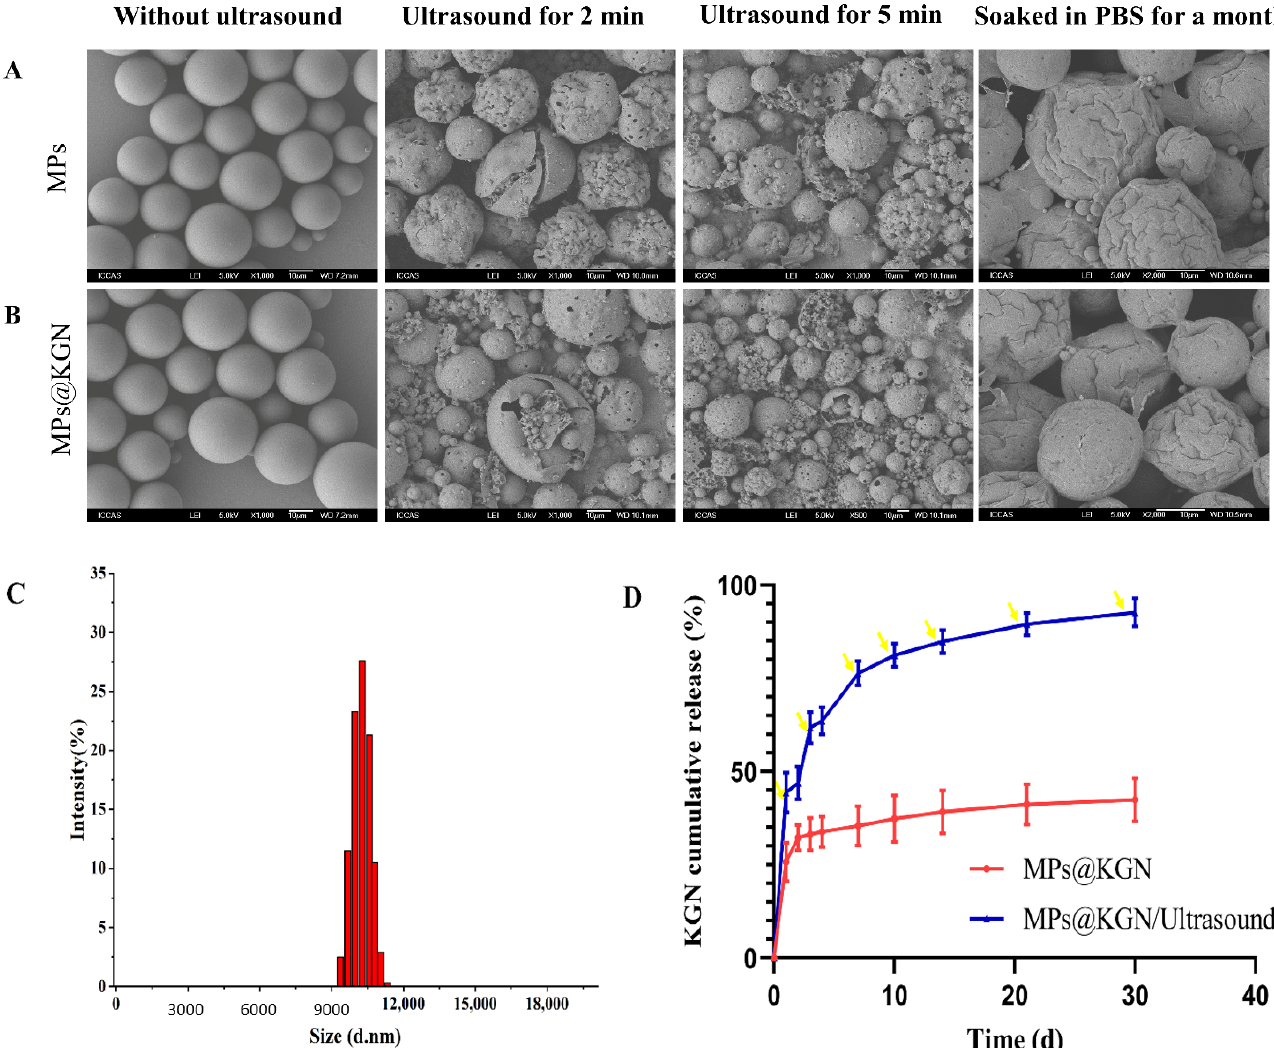
Figure 1. SEM images of MPs with and without KGN: ( A ) MPs without KGN; ( B ) MPs with KGN; ( C ) size distribution; ( D ) in vitro KGN release profiles of PLGA MPs and the yellow arrow represents ultrasound for 2 min. As shown in Figure 1C, histograms represented the size distribution of MPs. The di- ameter of MPs was found to be in the range of 9.2–11.8 μ m. Additionally, the medium sizes of MPs with and without KGN were 10.1 μ m. In general, owing to their high surface